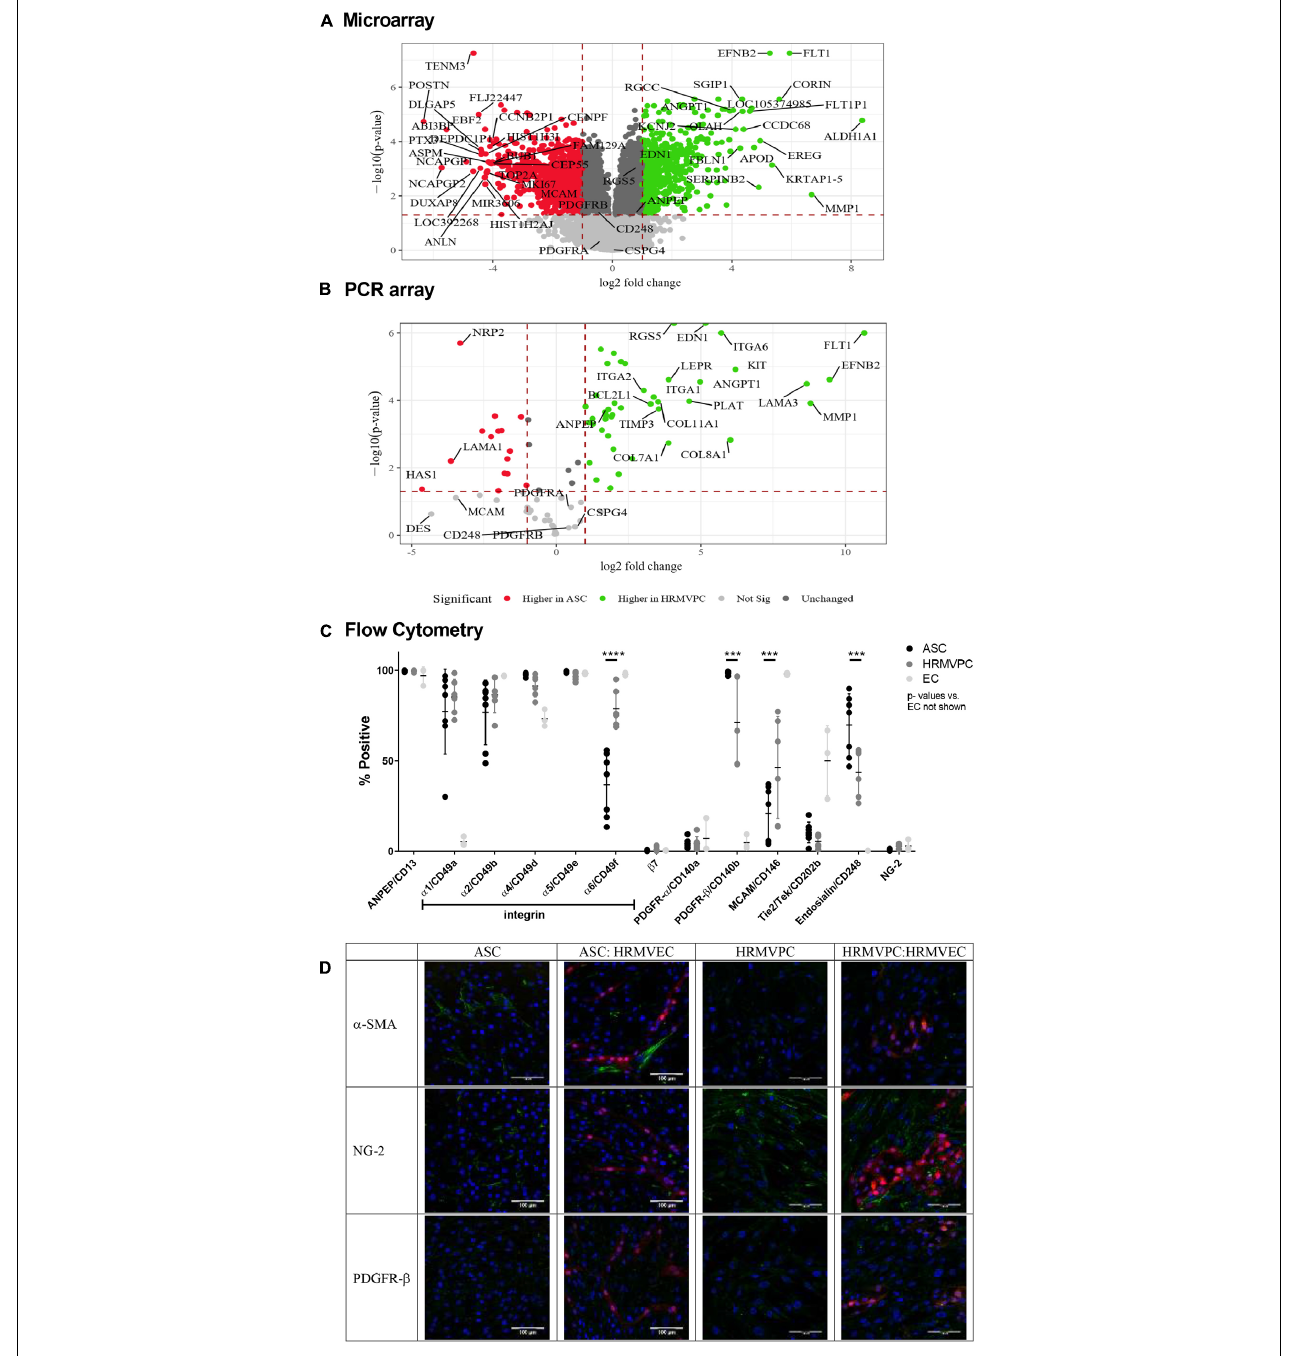
FIGURE 4 | Differential marker expression of adipose-derived stromal cells (ASC) and human retinal microvascular pericytes (HRMVPC) assessed by microarray, PCR array, flow cytometry, and immunofluorescence. (A) Volcano plot visualizing the microarray data showing the magnitude of change (log 2 -fold change, x -axis) vs. statistical significance [-log 10 ( p -value), y -axis] of gene expression of ASC vs. HRMVPC (each n = 3 biological replicates). Most differentially expressed genes and putative pericyte markers are labeled. (B) Validation of microarray results using PCR array. The correlation is high (Spearman correlation R = 0.95, p < 2.2e-16). Most differentially expressed genes and putative pericyte markers are labeled. (C) Marker expression in ASC, HRMVPC, and EC measured by flow cytometry. Percent positivity calculated against the unstained control [ n = 7 different ASC donors, n = 6 HRMVPC with three donors in independent experiments, n = 3 human umbilical vein endothelial cells and human retinal microvascular endothelial cells (HRMVEC); *** p ≤ 0.001 and **** p ≤ 0.0001, two-way ANOVA with Tukey’s post hoc test, p -values for EC not shown]. Correlation to microarray and PCR array is poor (Spearman correlation R = 0.4, p = 0.2) using mean fluorescence intensity values. (D) Representative pictures of marker expression (green) in ASC, HRMVPC, and the respective cocultures measured by two-photon microscopy. dTomato HRMVEC are shown in red. Scale bar, 100 µ m.